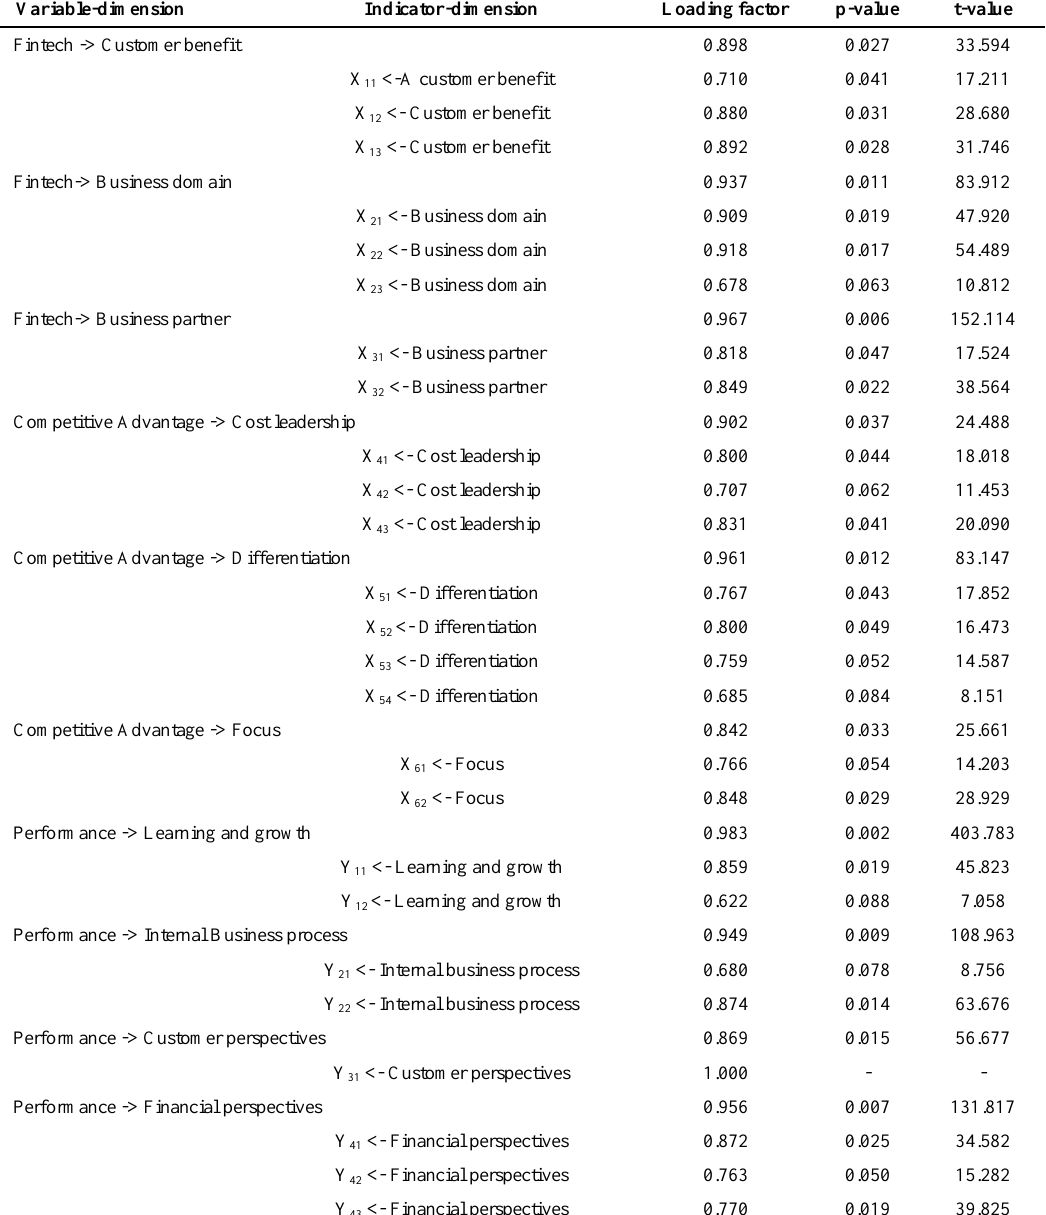
Table 2. Estimated measurement model